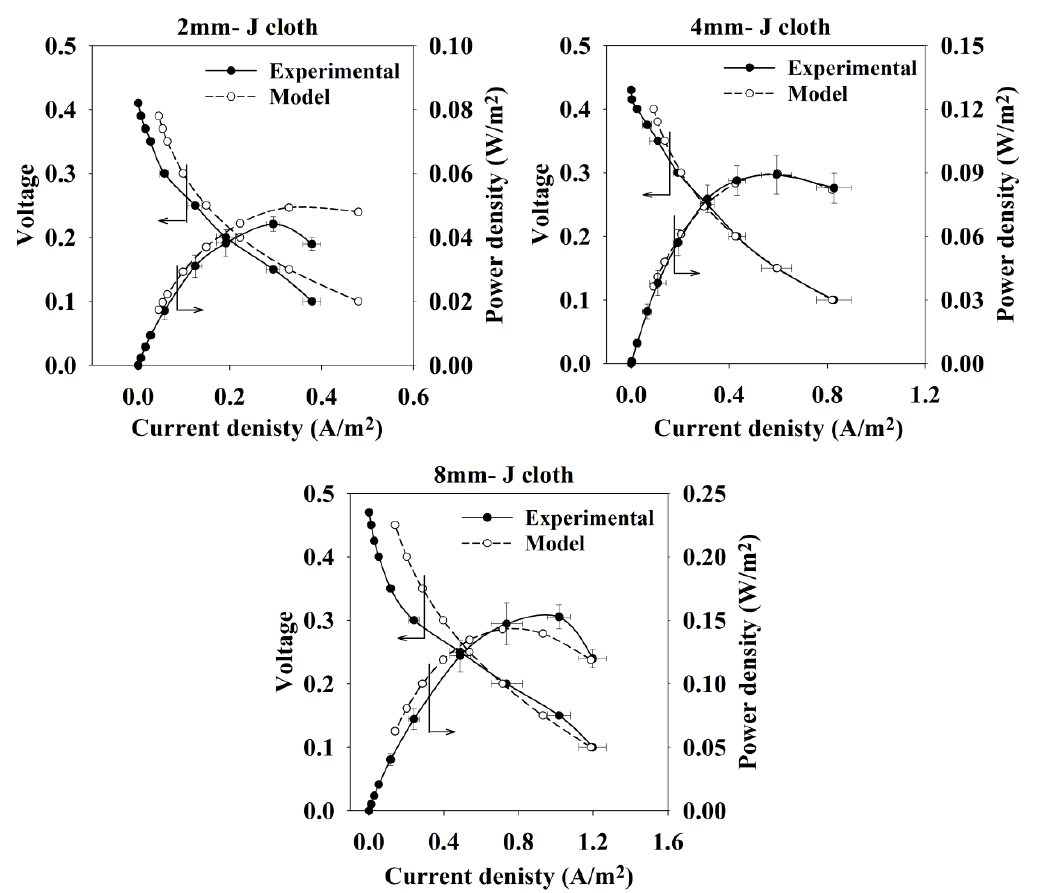
Figure 1. Predicted vs. experimental polarization and power density curves of the FPMFCs using J ‐ cloth as the separator.